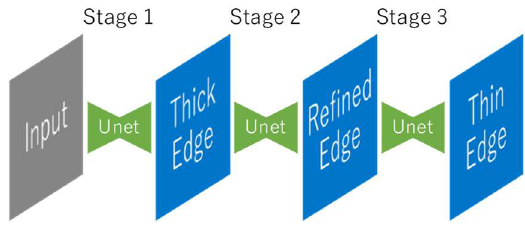
Figure 3. Conceptual diagram of proposed flow